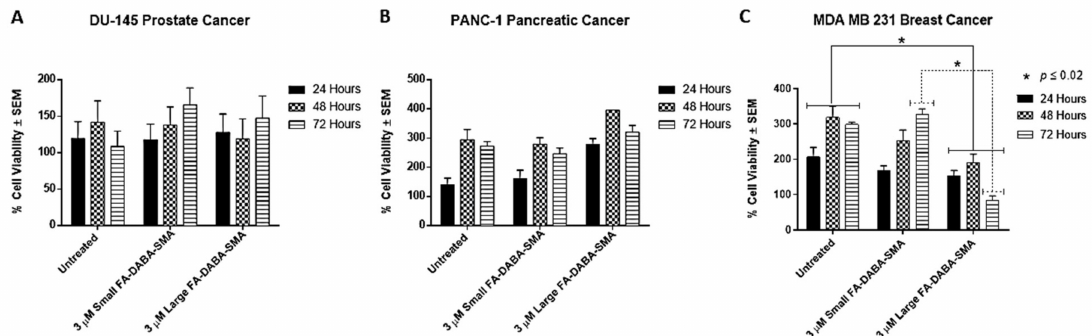
Figure 2. Di ff erential e ff ects of large and small FA-DABA-SMA nanopolymer on cell viability of DU-145 prostate, PANC-1 pancreatic and MDA-MB-231 breast cancer cells. Comparison of the cell viability of ( A ) DU-145, ( B ) PANC-1 and ( C ) MDA MB-231 cell lines at 24, 48 and 72 hours treated with a 20 kDa FA-DABA-SMA (small) and a 350 kDa FA-DABA-SMA (large) nanopolymer using the WST-1 assay. Results were compared by a one-way ANOVA at 95% confidence using Fisher’s LSD test. The data (triplicates) are one of two separate experiments with similar results. The significance is reported in comparison to the untreated control at the respective time point (solid line) and as a comparison between 350 kDa and 20 kDa nanopolymers (dashed